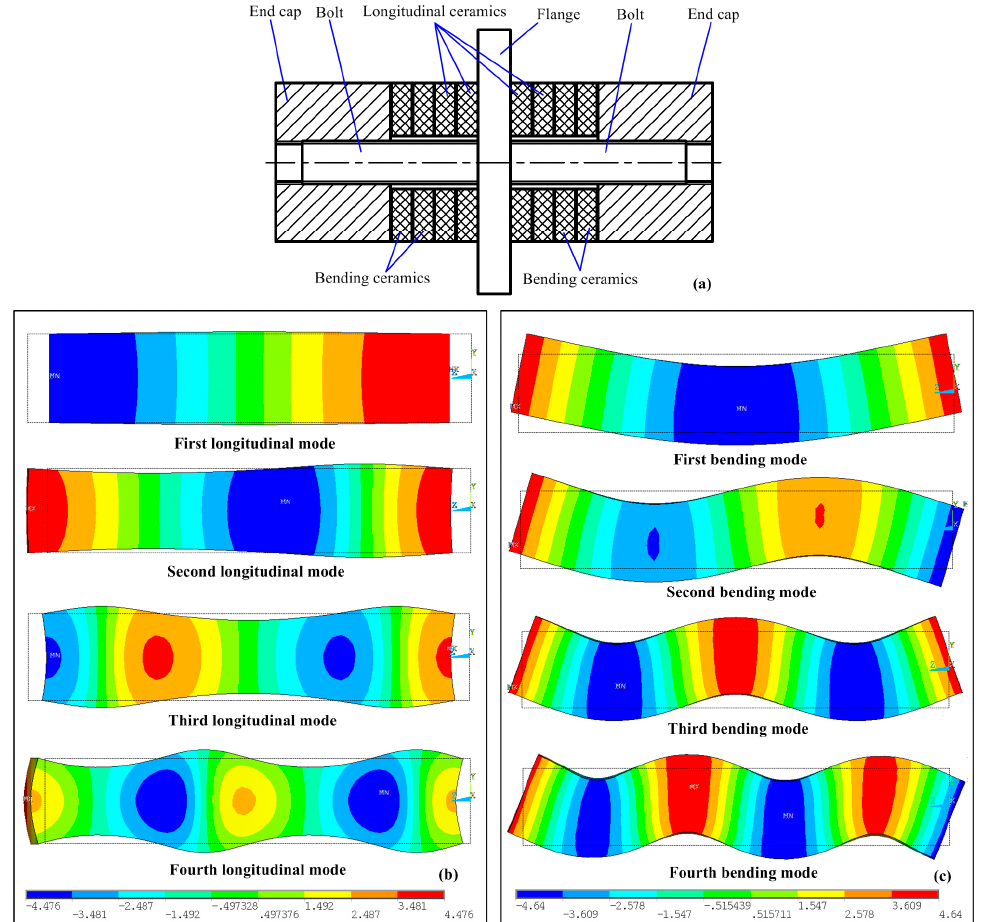
Figure 1. ( a ) The common structure of a sandwich transducer operating in longitudinal-bending hybrid modes; ( b ) longitudinal vibration modes of a beam with a square-shaped cross-section; ( c ) bending vibration modes of a beam with a square-shaped